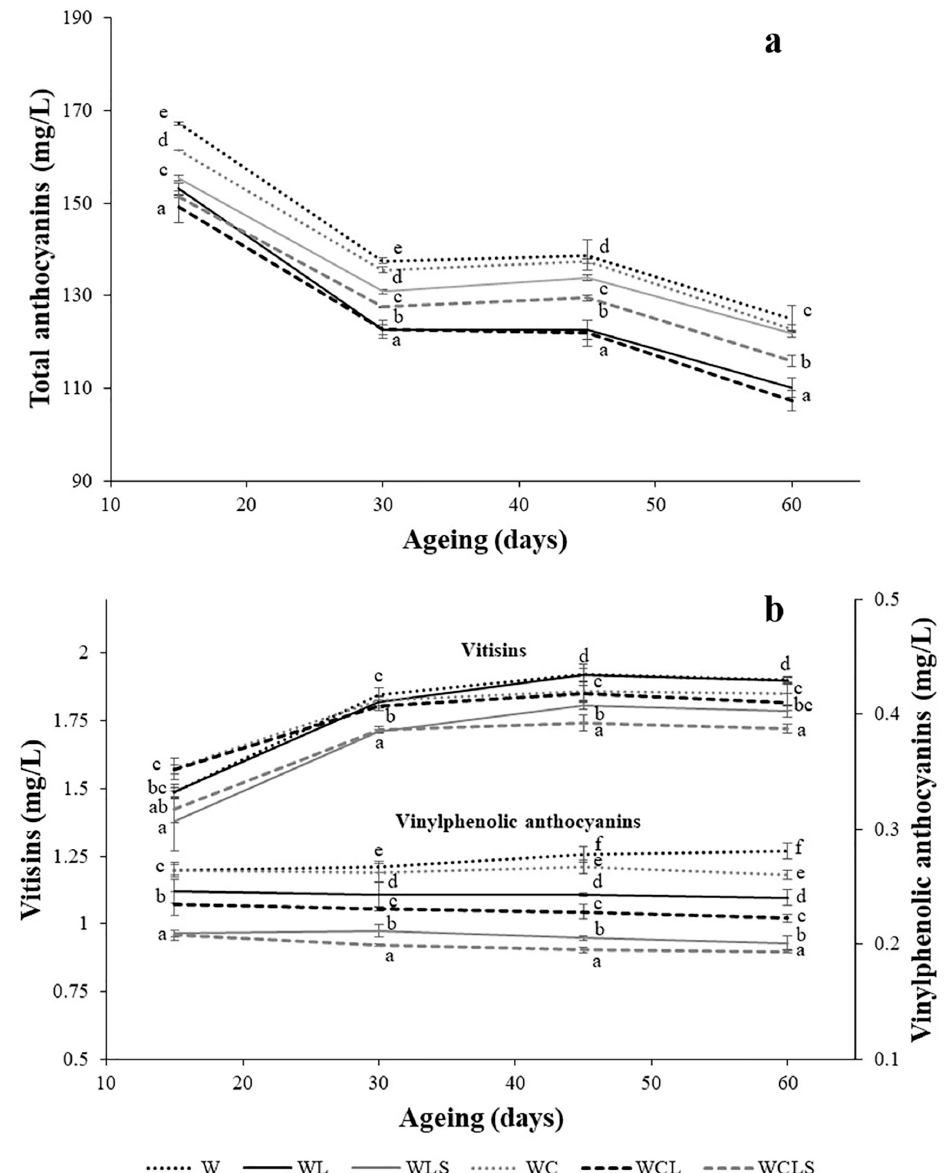
Figure 4. Total anthocyanins (mg/L) ( a ), vinylphenolic anthocyanins (mg/L) and vitisin content (mg/L) ( b ), throughout the AOL, in red wines. W—control wine; WL—wine with lees; WLS—wine with sonicated lees; WC—wine with oak chips; WCL—wine with lees and oak chips; WCLS—wine with sonicated lees and oak chips; ML—hydroalcoholic solution with lees; MLS—hydroalcoholic solution with sonicated lees. Mean ± standard deviation of three replicates. Different letters in axes X indicate values with statistical significant differences ( p < 0.05).